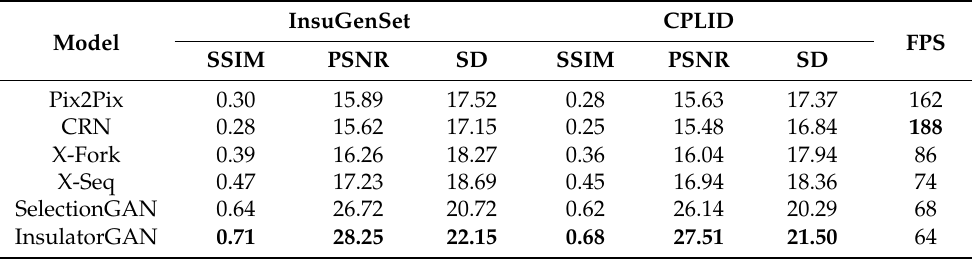
Table 5. SSIM, PSNR, and SD of the different models. FPS is the number of images processed per second during testing.